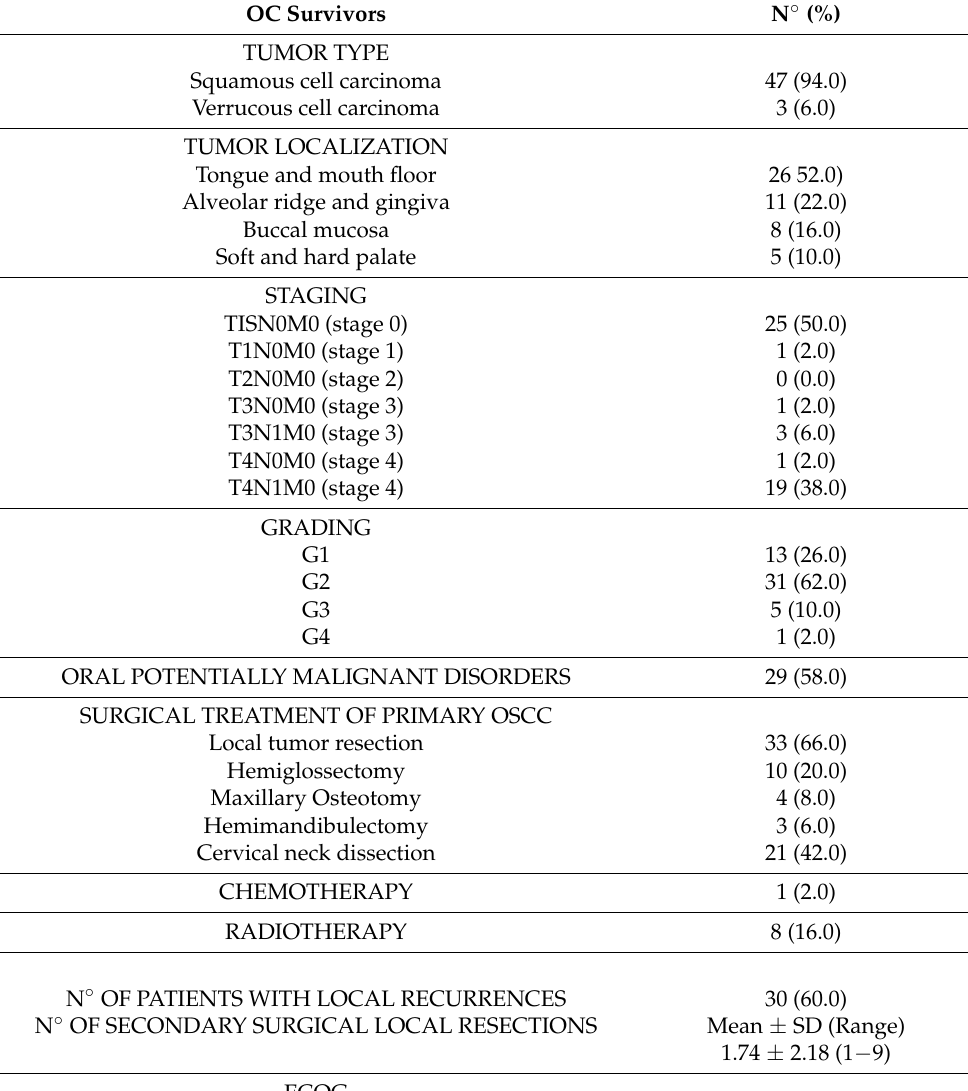
Table 3. Medical characteristics of the OC